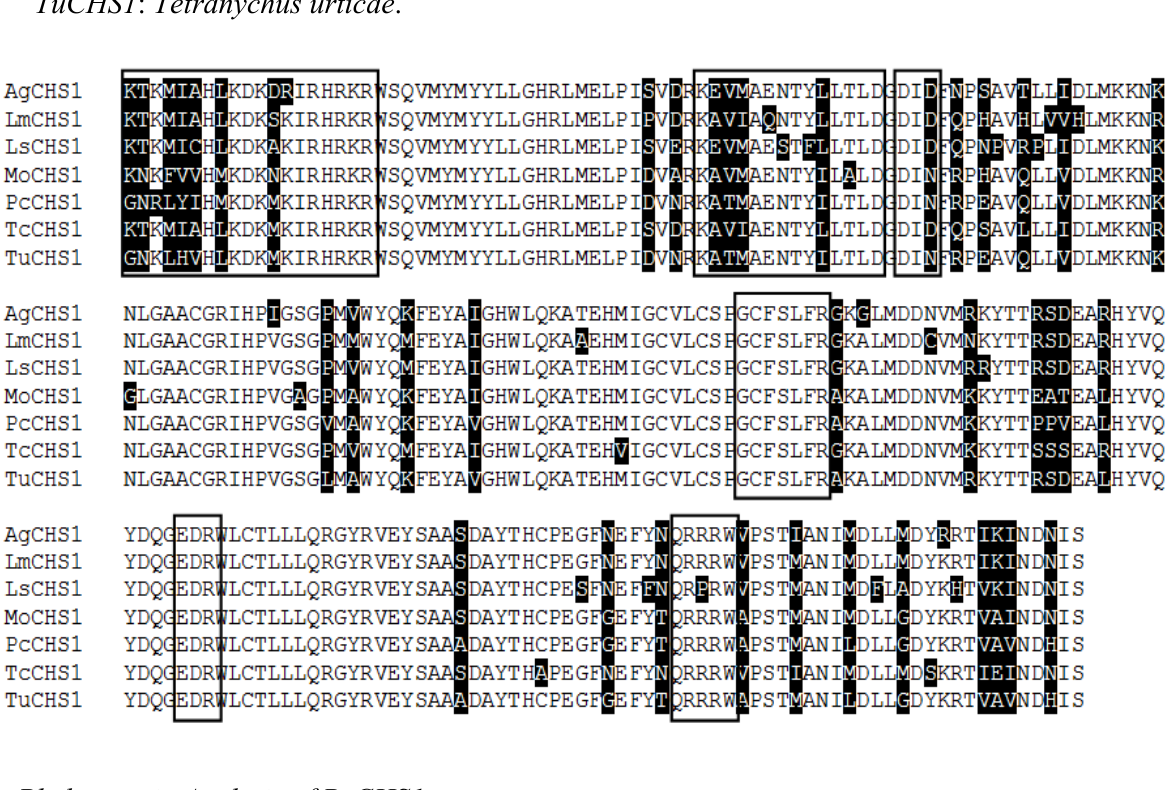
Figure 2. ClustalW alignment of putative conserved catalytic domains of chitin synthases genes from three mites and four insect species. Conserved domains with identical amino acid residues are shown with white backgrounds. Six black boxes of amino acid residues refer to the highly conserved regions in glycosyltransferases enzymes